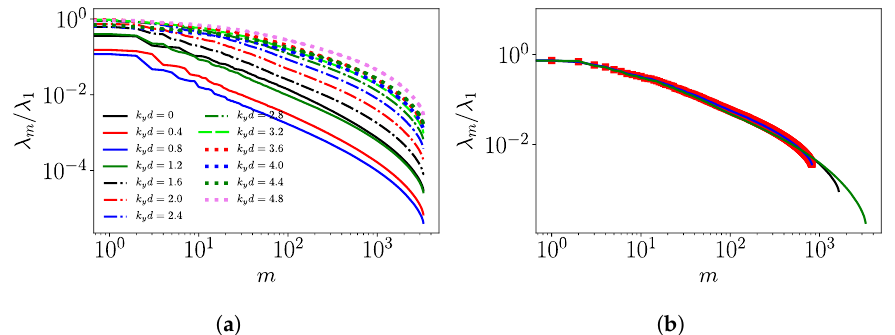
Figure 11. ( a ) Normalized eigenspectra λ m / λ 1 for different wavenumbers k y for the Fourier-POD modes. ( b ) Convergence of the normalized eigenspectra λ m / λ 1 for wavenumber k y d = 2. Different snapshot spacing, T e /5—green, 2 T e /5—black, 4 T e /5—blue, 4 T e /5 (not considering the reflected data)—red